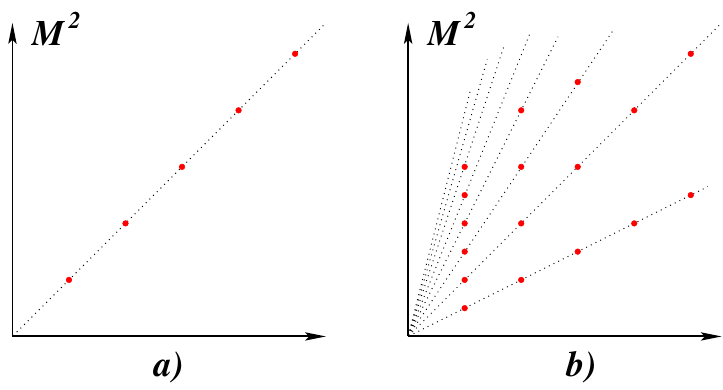
Figure 16 . In the large N c limit the spectrum of non-supersymmetric ( N = 0) QCD 2 with N f = 1 has one asymptotically linear Regge trajectory ( a ), and in(cid:12)nitely many Regge trajectories (with integer slopes) for N f = N c or one massive matter multiplet in the adjoint representation ( b ). when N = N quarks become massless or when the mass of the adjoint matter c f